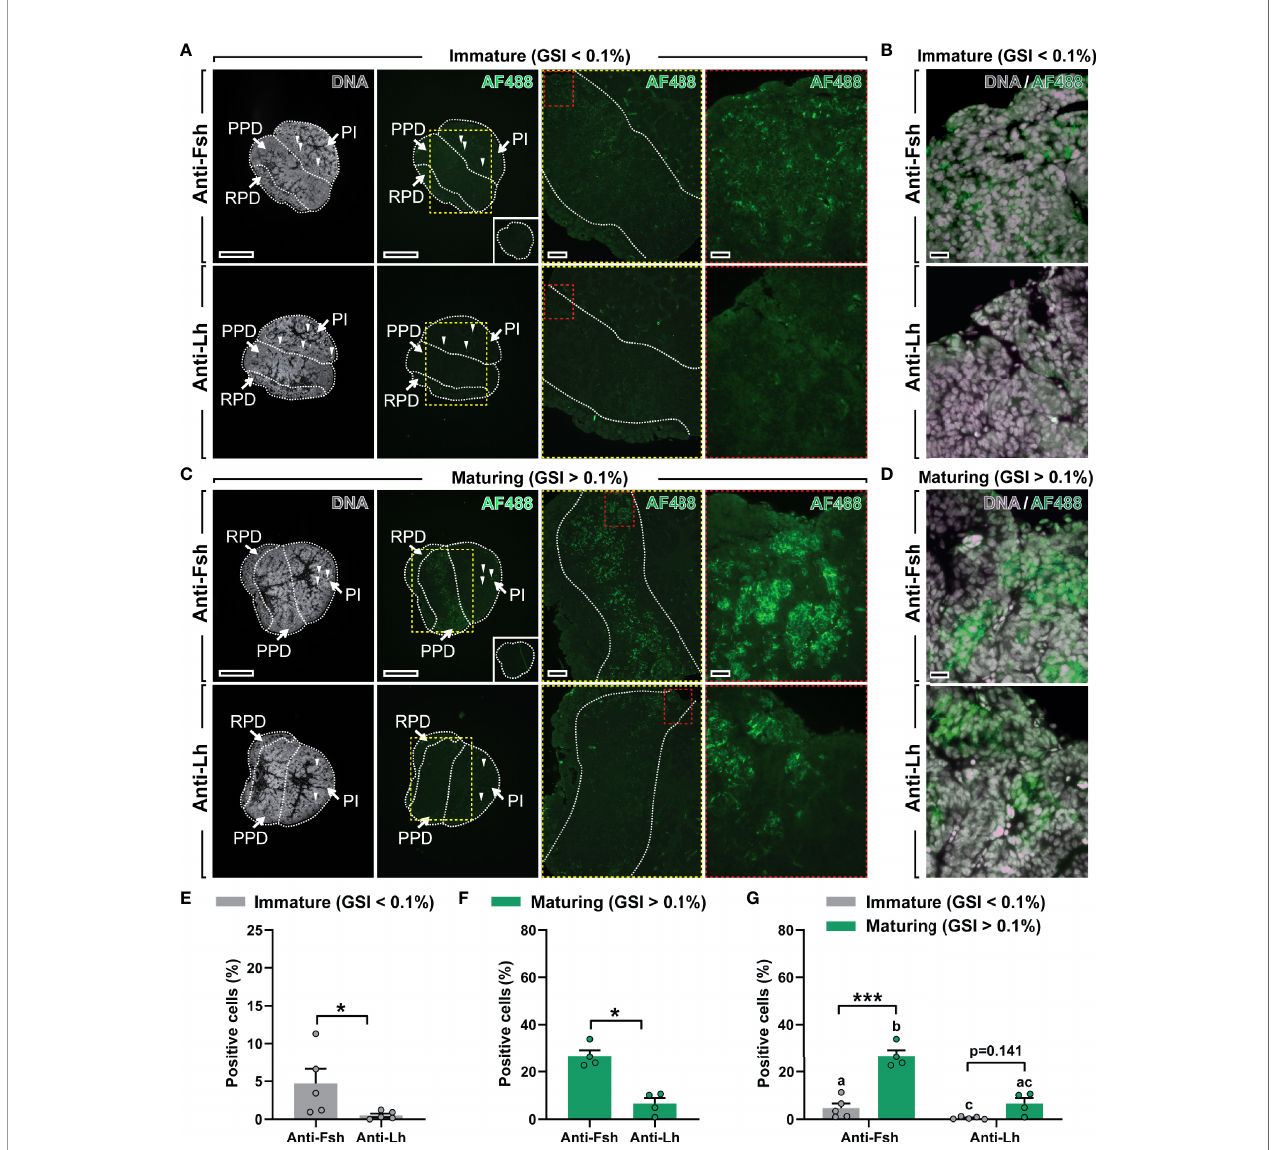
FIGURE 3 | Localization and quanti fi cation of Fsh and Lh cells in immature and maturing male salmon pituitaries. (A – D) Immunolocalization of Fsh and Lh proteins in serial sections (sagittally oriented; anterior to the left) of immature and maturing salmon pituitaries using the Atlantic salmon Fsh antiserum generated in this study and an anti-(coho salmon)Lh antibody previously validated (18). Right panels in (A) and C show pituitary tissue magni fi ed from the marked areas (yellow and red dashed lines; scale bar = 200 µm and 50 µm, respectively). Scale bar in low magni fi cation pictures = 500 µm. Negative control (pre-immune serum) for Fsh immunostaining showed no speci fi c staining (insets in right lower panels in (A, C) . Arrowheads indicate red blood auto fl uorescence. Further magni fi ed areas of pituitary tissue of immature (B) and maturing (D) male salmon do not seem to show clear Fsh/Lh co-localization in serial sections (scale bar = 20 µm). Propidium iodide (in grey) was used as nuclear counterstain. GSI, gonado-somatic index; AF488, Alexa Fluor 488; PPD, proximal pars distalis ; PI, pars intermedia ; RPD, rostral pars distalis . (E – G) Quanti fi cation of the percentage of Fsh- and Lh-positive cells in immature (E) and maturing (F) pituitaries, and combined (G) . Data are shown as mean ± SEM (N = 4-5; *p < 0.05; ***p < 0.001), and expressed relative to the total number of cells. In (G) , different letters indicate signi fi cant differences between